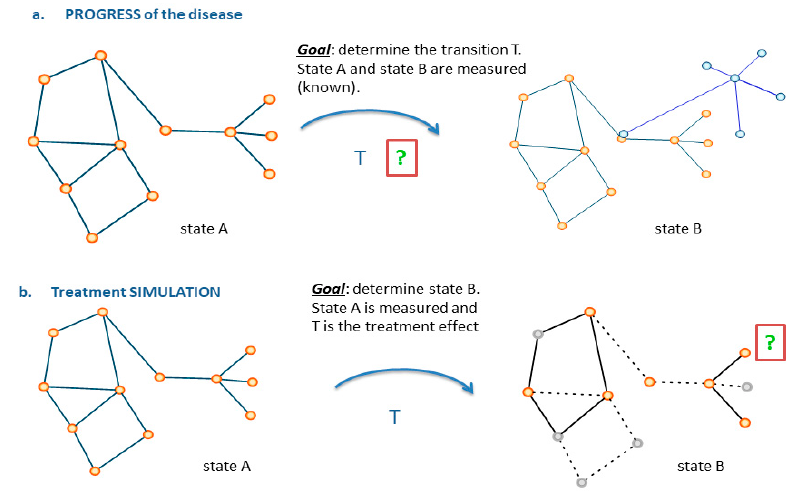
Figure 4. Use of networks to monitor disease progression ( a ) and simulate treatment ( b ). T is defined as general transition between states in the top panel, and as treatment (specifying the nature of transition) in the bottom panel. Two states are characterized, and the arrival state B is modified relatively to originating state A by the effect of T.